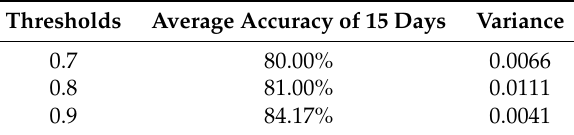
Figure 7. Accuracy of different thresholds. Table 3. Accuracy analysis of different thresholds.